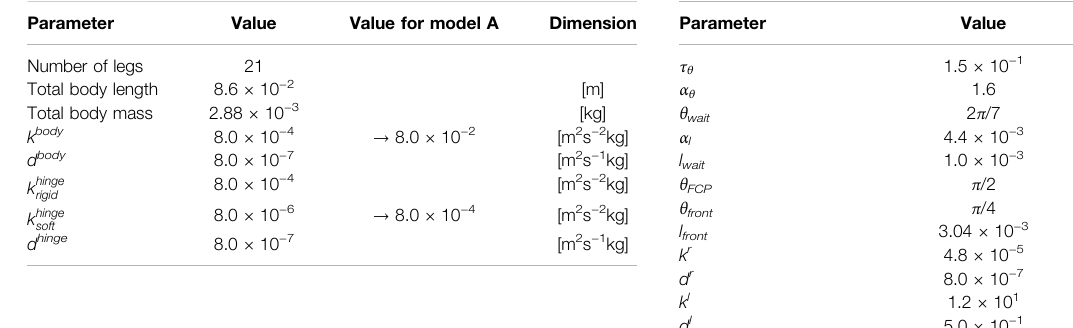
of the leg motion during stance phase. S ventral